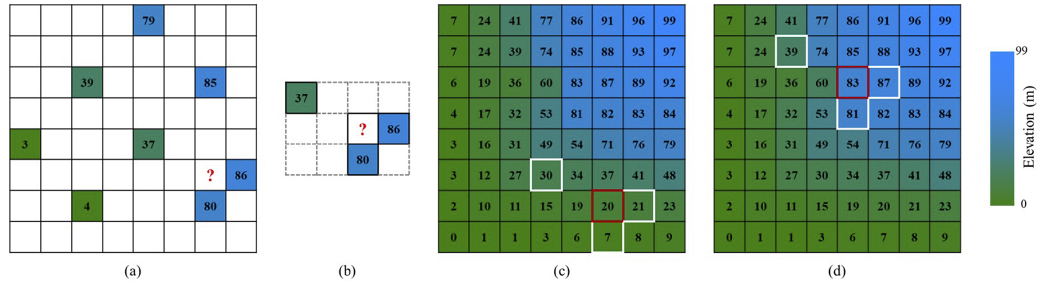
Figure 3. Conceptual example of the DS point simulation. (a) Radar lines on the simulation grid; (b) three known points (values: 37, 80, 86) constitute a conditioning data pattern; (c) a mismatch pattern in TI; (d) a similar pattern in TI.